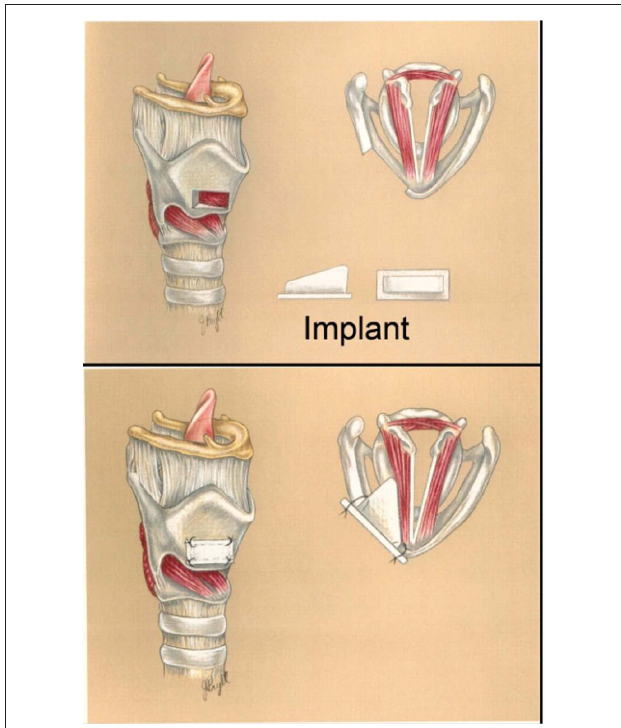
Figure 4 | Medialization laryngoplasty